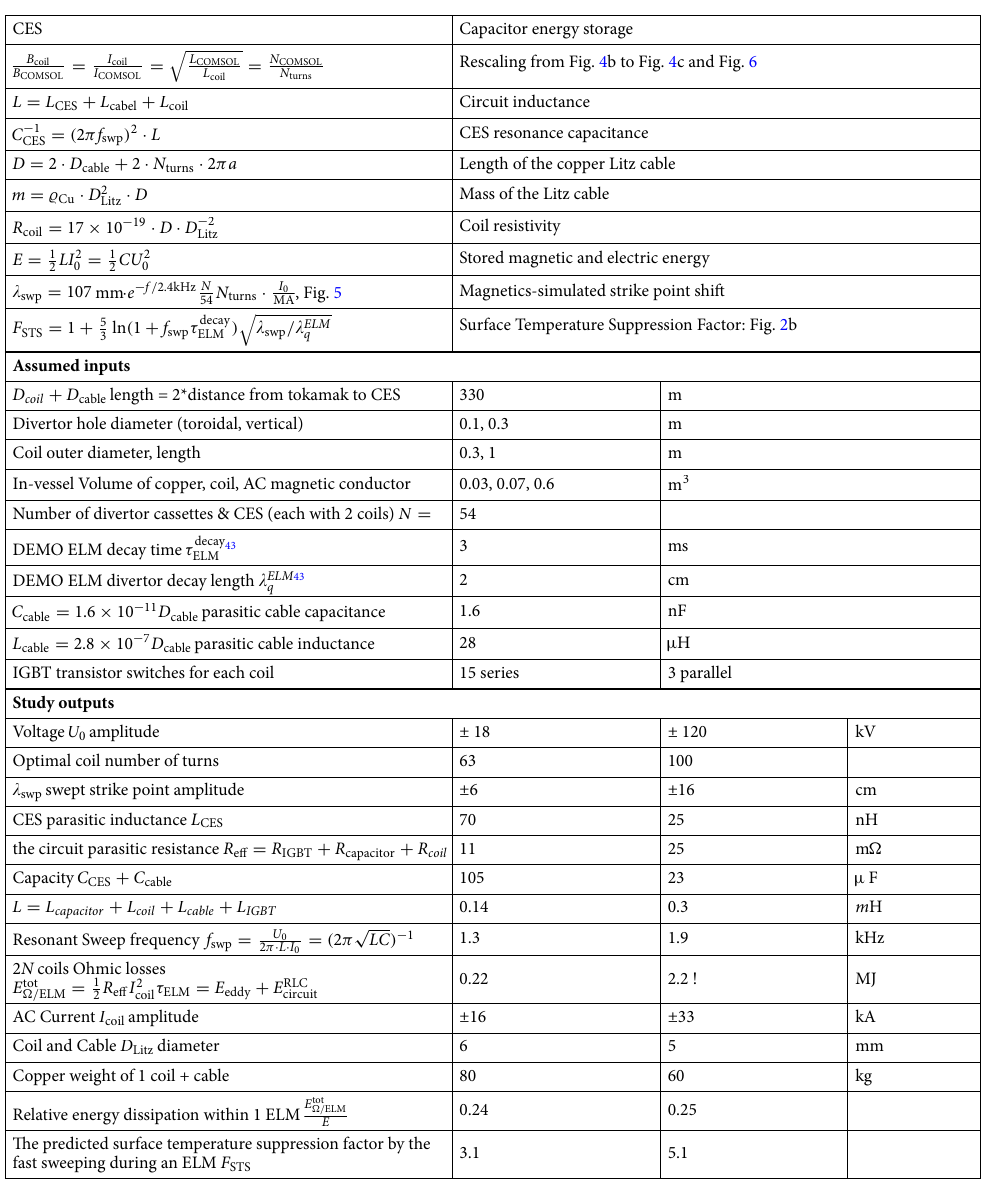
Table 2. The sweeping system parameters for the DEMO fusion tokamak. One coil, cable and CES (capacitor with IGBT switch) assumed in each 54 divertor cassettes. The coil number of turns is set in order to maximize F STS from Fig. 6. Due to too high voltage and especially the total ohmic losses of the entire system, we consider as feasible only the 18 kV